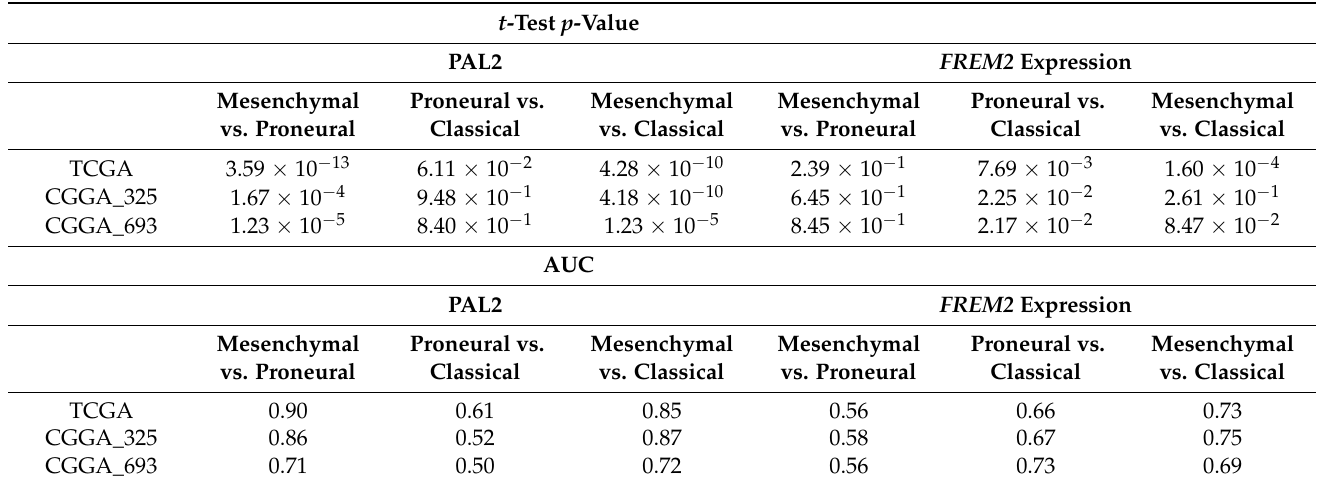
Table 3. Performance of FREM2 expression and FREM2 pathway activation for discrimination of GBM molecular subtypes.